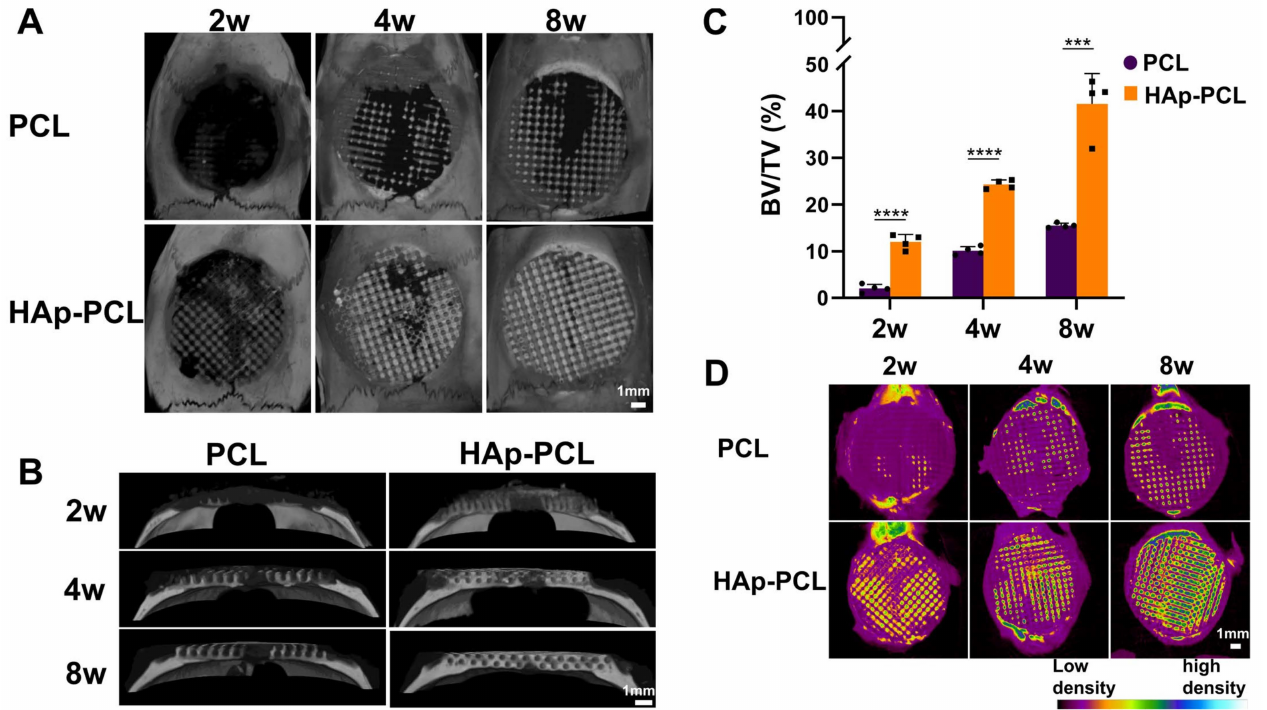
Figure 5. µ -CT analysis of bone formation at 2, 4, and 8 weeks after implantation of PCL or HAp-PCL into critical-sized calvaria bone defects in rats. The µ -CT images were acquired from the axial ( A ) and coronal ( B ) planes of the defective site. ( C ) Time profiles of bone volume/total volume (BV/TV). The bone volume for the HAp-PCL group were calculated by subtracting the value of scaffold-derived hydroxyapatite from that of the original signal. ( D ) Bone mineral density (BMD) images obtained from the axial plane of µ -CT. *** p < 0.001, **** p < 0.0001: significant difference between two groups at the corresponding